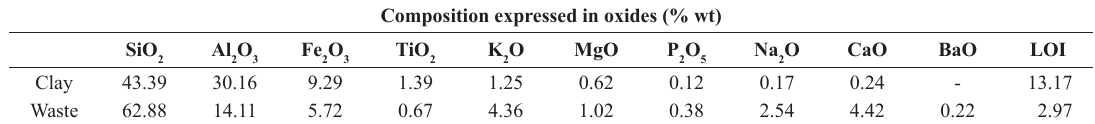
Figure 1. Examples of burned bars of clayey mass with dimension stone waste (after rupture) with contents from 10% to 90% (wt) after rupture. Table 1. Chemical composition of clay and dimension stone waste by